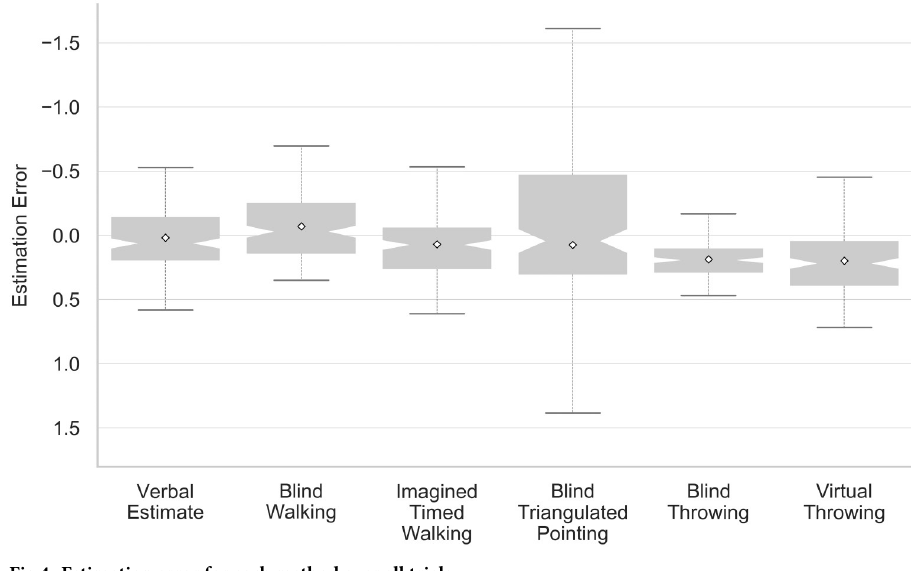
Fig 4. Estimation error for each method over all trials.